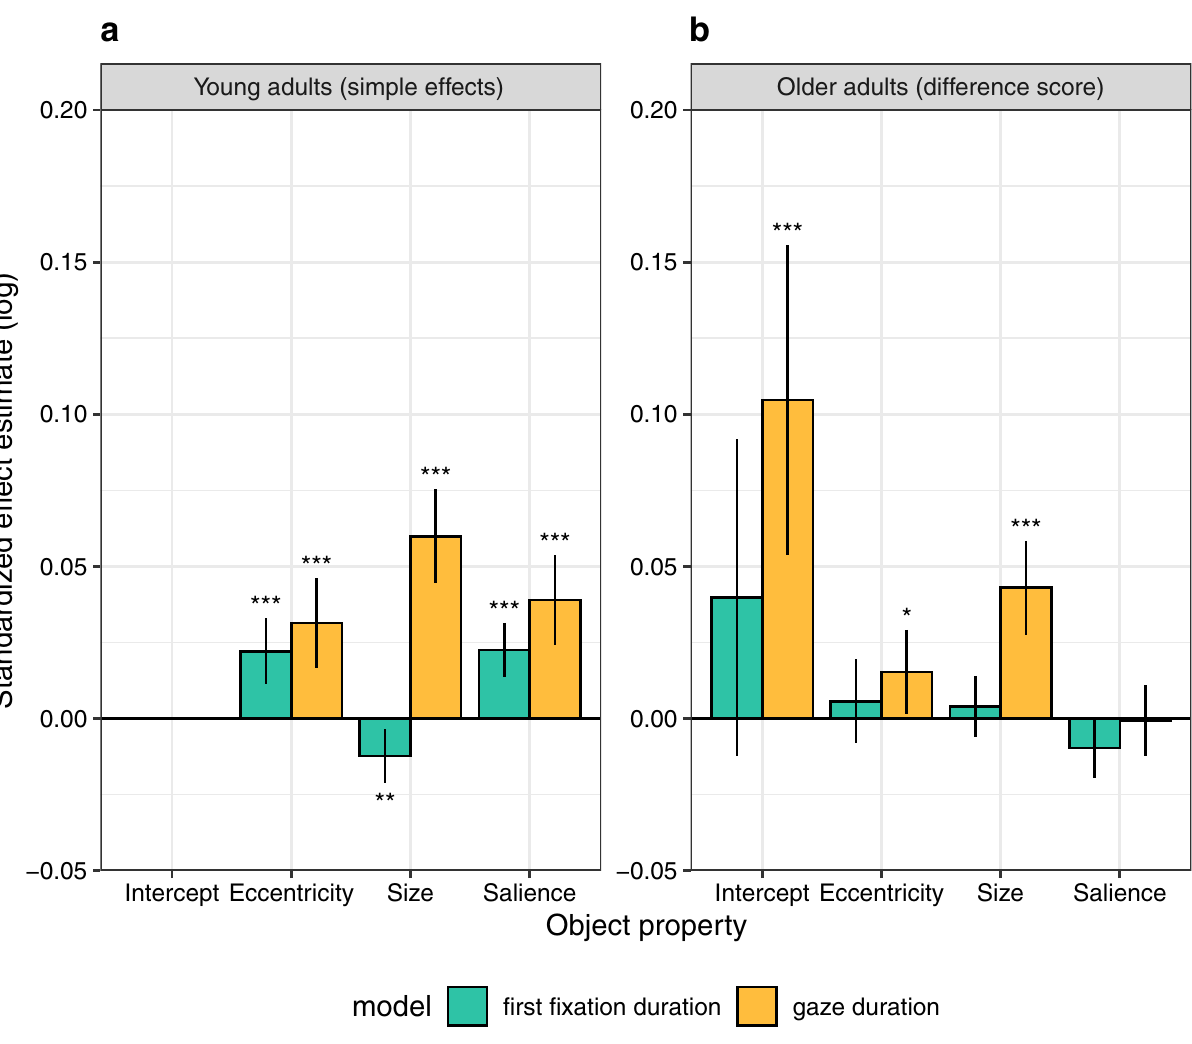
Figure 5. Fixed-effects results for linear mixed models fitting log-transformed fixation times for objects in scenes. One model evaluated first-fixation duration (green bars), the other one gaze duration (orange bars). Both models compared data for young and older adults. ( a ) Effects that were estimated for the young adults; the large coefficients for the intercept were not visualised (but see Table 3). ( b ) Difference scores, describing the difference between older and young adults. Error bars indicate 95% confidence intervals. Stars denote coefficients that were significantly different from zero (* | t |> 1.96, ** | t |> 2.576, *** | t |>